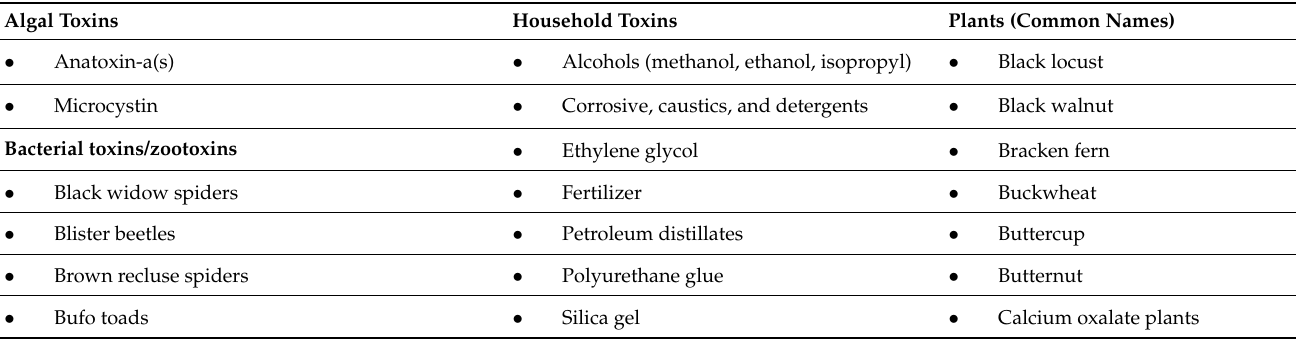
Table A1. Toxic agents covered in one or more veterinary toxicology